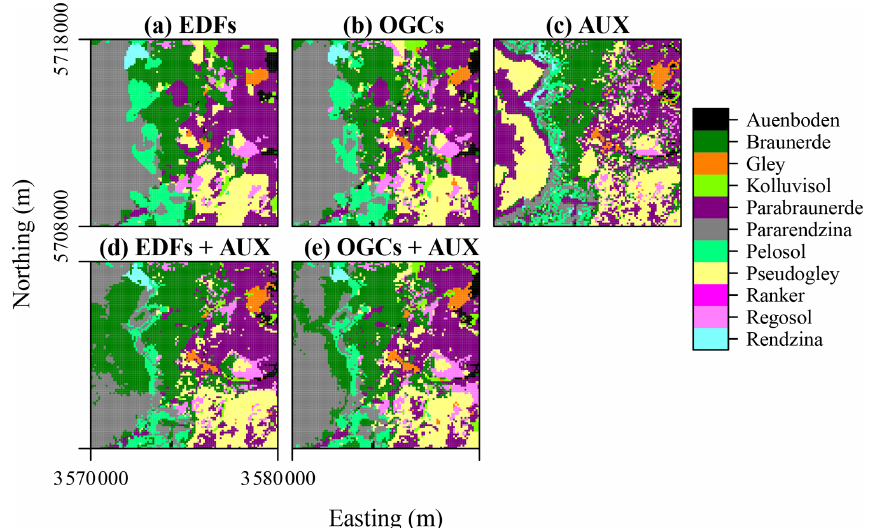
Figure 10. Soil types predicted with each method for the eberg dataset. Easting and northing are coordinates according to DHDN/Gauss– Krueger zone 3 (German coordinate system). (a) Euclidean distance fields (EDFs), (b) oblique geographic coordinates (OGCs), (c) auxiliary data (AUX), (d) EDFs combined with AUX, and (e) OGCs combined with AUX.